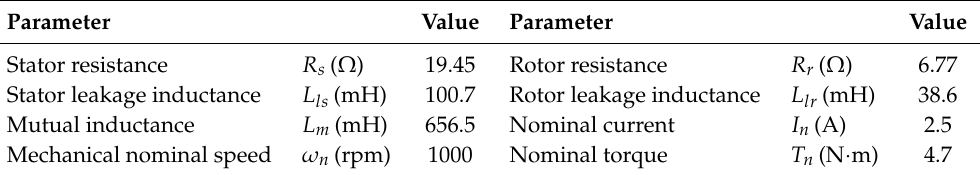
Figure 2. Photographs of the various elements of the experimental setup. Table 1. Estimated parameters of the